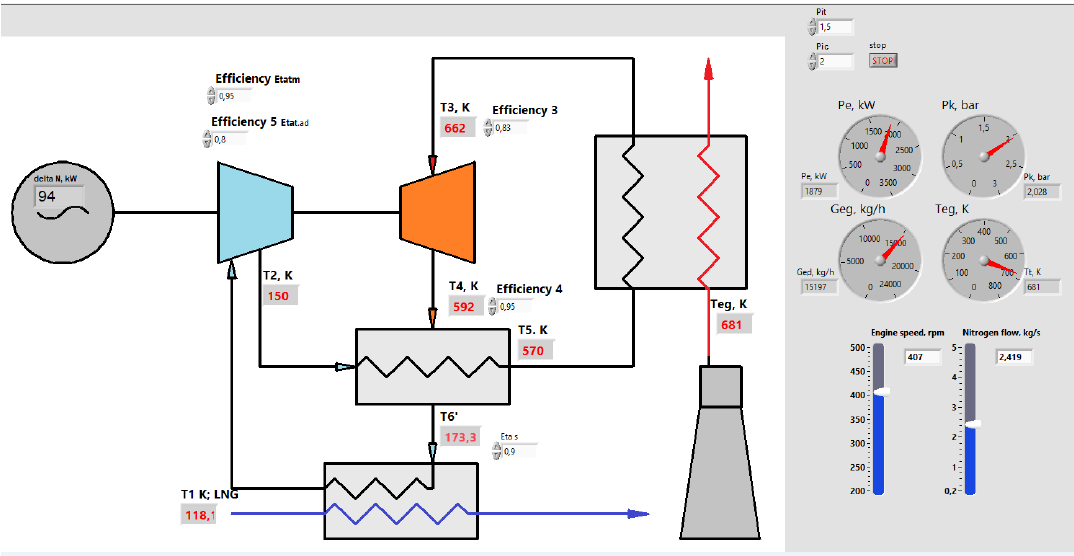
Figure 3. Fragment of an LNG ship power plant cogeneration cycle simulator.